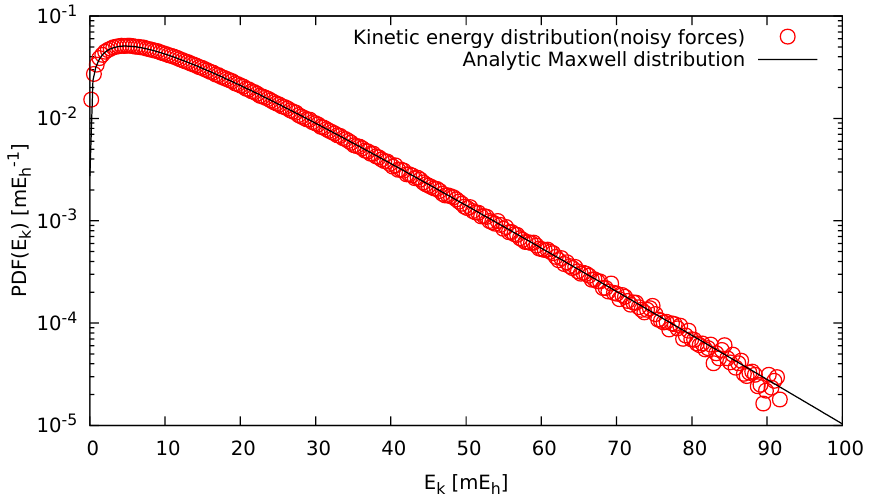
Figure 3. Kinetic energy distribution of liquid Si at 3000 K, as obtained by our simulations using noisy forces (circles). For comparison, the analytic Maxwell distribution is also shown